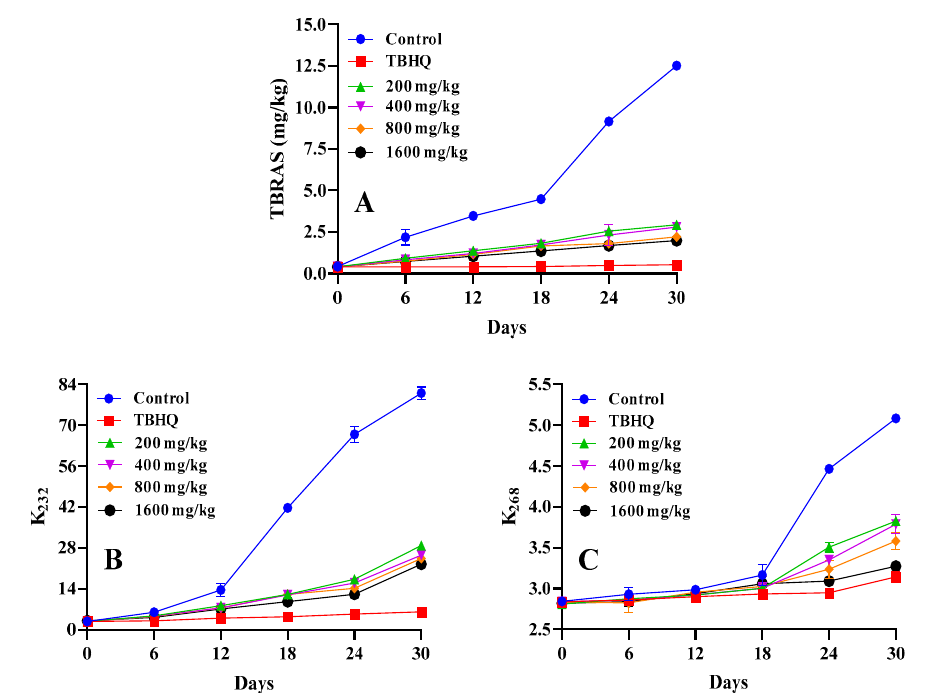
Figure 3. The influences of HCEO on TBRAS ( A ), K 232 ( B ) and K 268 ( C ) of sunflower oil samples during the accelerated storage. Values are expressed as means ± SD ( n = 10). (Control) sunflower oil added with nothing. (TBHQ) sunflower oil added with TBHQ at 200 mg/kg, (200 mg/kg) sunflower oil added with HCEO at 200 mg/kg, (400 mg/kg) sunflower oil added with HCEO at 400 mg/kg, (800 mg/kg) sunflower oil added with HCEO at 800 mg/kg, (1600 mg/kg) sunflower oil added with HCEO at 1600 mg/kg. TBRAS, Thiobarbituric acid reactive substance, K 232 , conjugated dienes, K 268 , conjugated trienes.